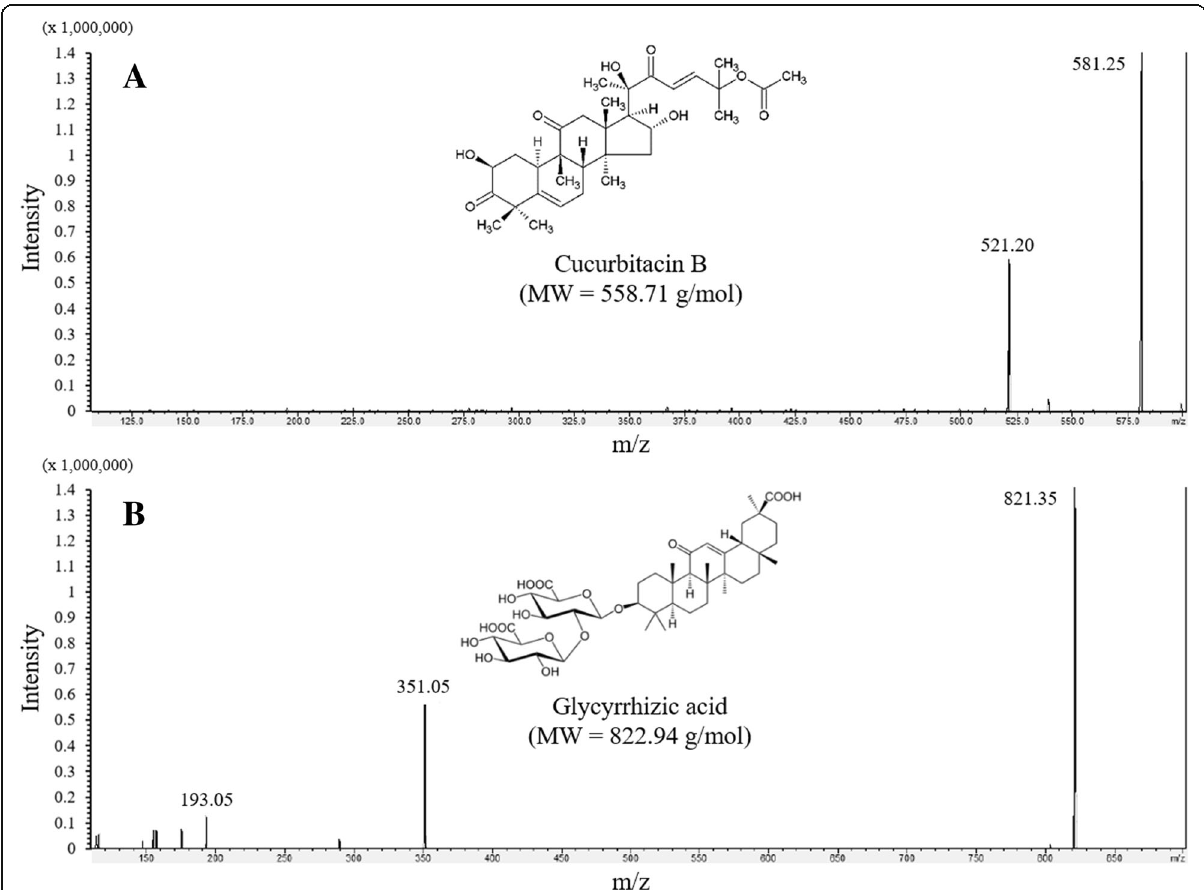
Fig. 1 Product ion scanning of parent ions and fragmentation patterns for cucurbitacin B ( a ) and glycyrrhizic acid, internal standard ( b